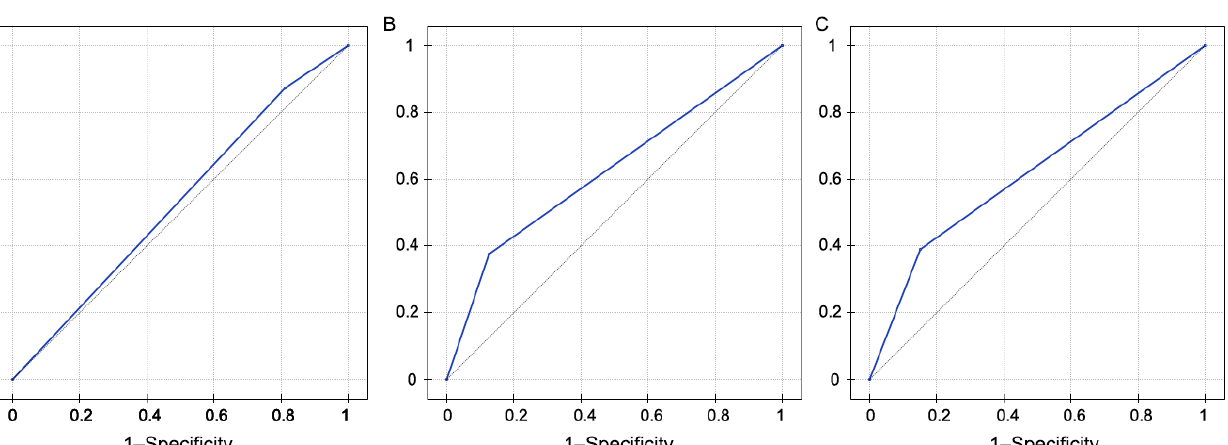
Figure 2. Optimal cut-off values for GCIPL ( A ) and pRNFL ( B ) thicknesses in the investigated cohort estimated by ROC analysis. ROC, receiver operating characteristic; GCIPL, ganglion cell–inner plex- iform layer; pRNFL, peripapillary retinal nerve fiber layer. 4. Discussion We conducted a cross-sectional study to evaluate the usefulness of pRNFL and GCIPL thickness thresholds for single-time-point SS-OCT measurements in differentiat- ing clinical outcomes in the real-world cohort of treatment-naïve pwMS without ON his- tory. We found that for pRNFL thickness thresholds (87 µm and 88 µm, respectively), sig- nificant differences were observed in relation to the disease type. Importantly, no CIS pa- tient had pRNFL thickness ≤87 µm. Furthermore, patients with pRNFL ≤87 µm as well as ≤88 µm had significantly longer disease duration and more advanced disability compared to those with greater pRNFL thickness. Importantly, such differences have not been